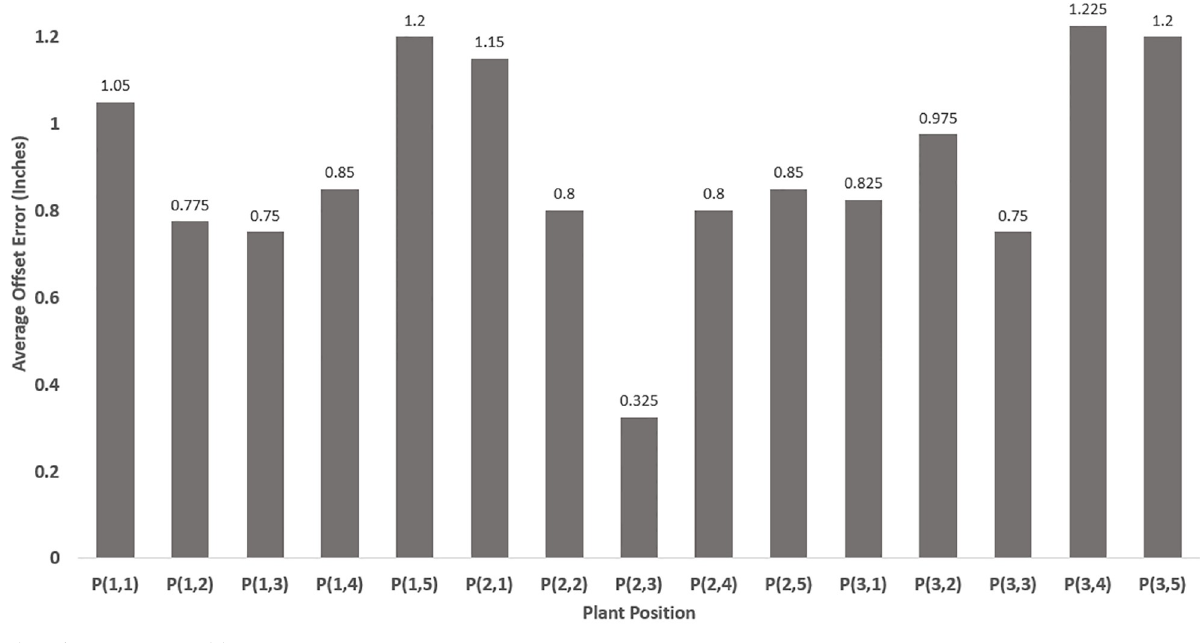
Fig 8. Average spray position